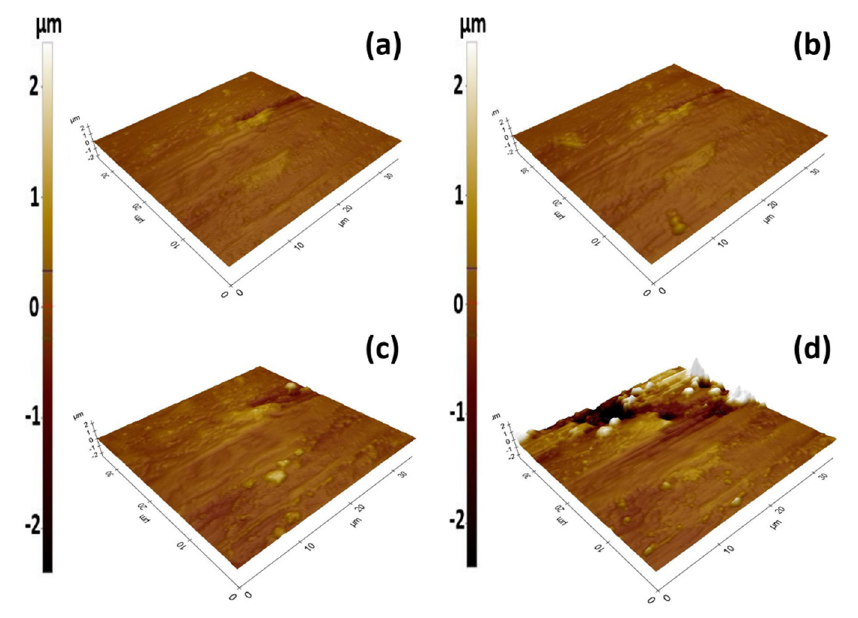
Figure 8. Three–dimensional surface topography image for bare aluminum alloy at ( a ) initial state, ( b ) after 1 min of accelerated corrosion, ( c ) after 2 min of accelerated corrosion, ( d ) after 3 min of accelerated corrosion.